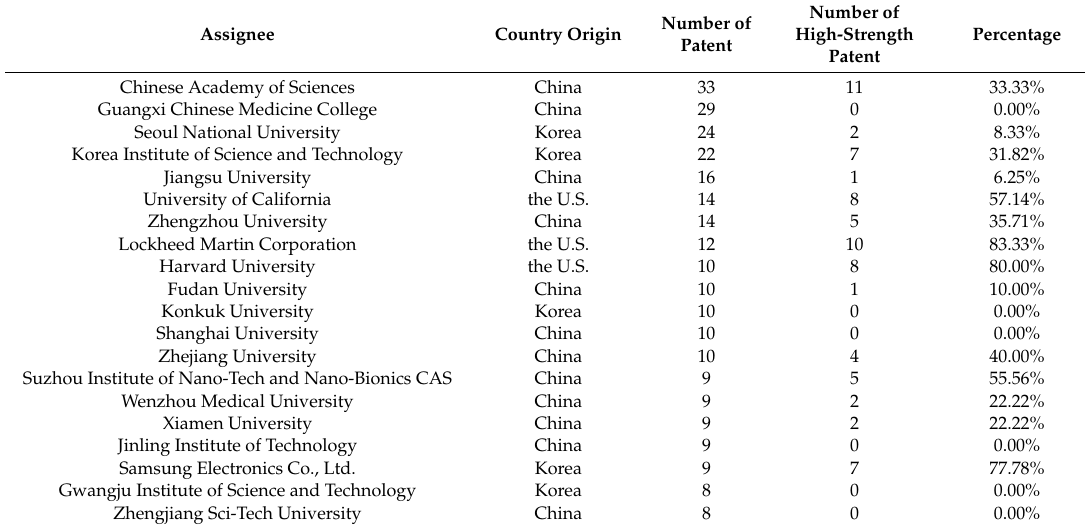
Table 1. Top 20 assignees holding high-strength